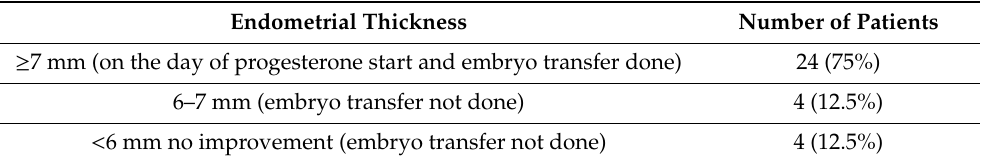
Table 1. Endometrial thickness following platelet rich plasma (PRP) administration.